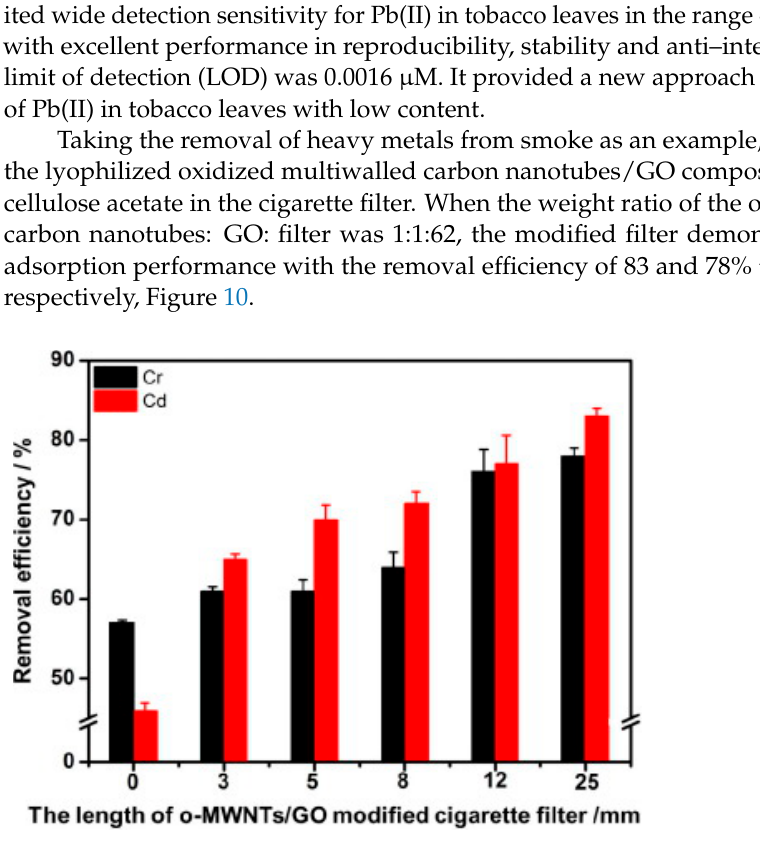
Figure 10. The effect of the length of o − MWNTs/GO modified cigarette filter on Cd(II) and Cr(VI) removal from mainstream smoke (with a dosage of 4 mg). Reprinted with permission from [98]. Copyright@ Elsevier.